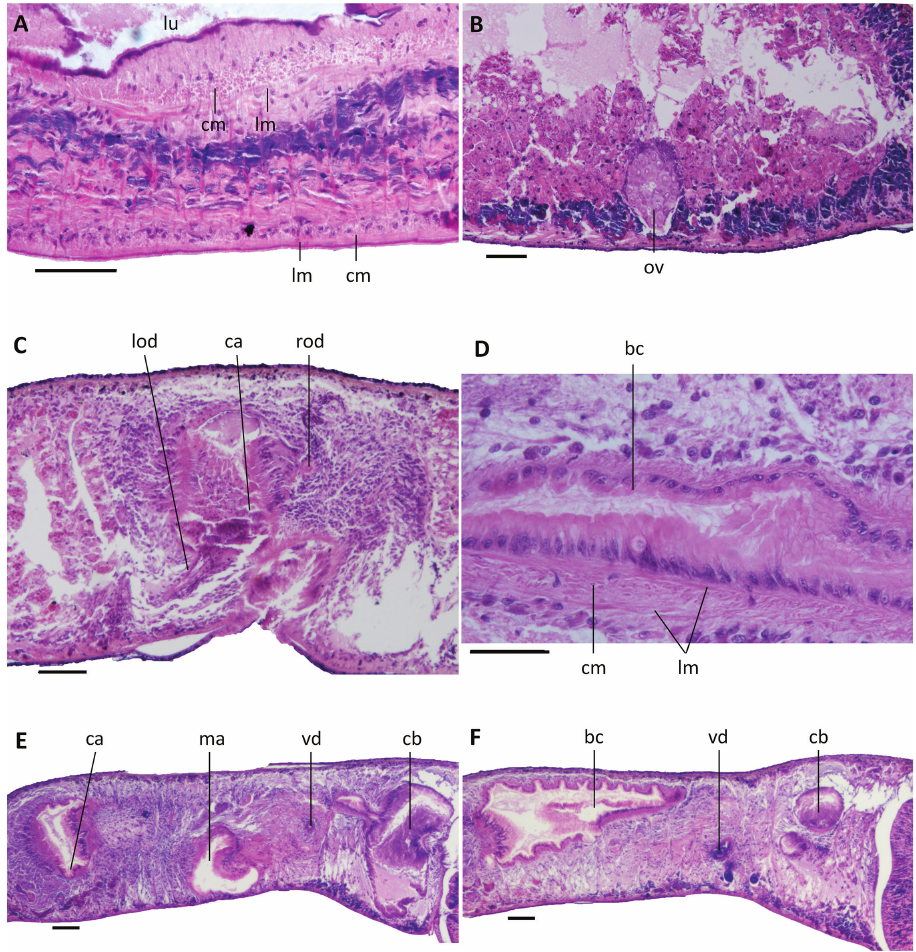
Figure 11. Dugesia verrucula A sagittal section of paratype RMNH VER. 19975.a, showing the musculature of the pharynx B sagittal section paratype RMNH VER. 19975.a, showing an ovary C transverse section of paratype ZJYA7, showing asymmetrical openings of the oviducts D sagittal section of paratype ZJYA11, showing musculature of bursal canal E sagittal section of paratype ZJYA11, showing copulatory bursa F sagit- tal section of paratype ZJYA11, showing wide portion of bursal canal, with its pleated walls. Abbreviations: bc: bursal canal; ca: common atrium; cb: copulatory bursa; cm: circular muscles; lm: longitudinal muscles; lod: left oviduct; lu: lumen; ma: male atrium; ov: ovary; rod: right oviduct; vd: vas deferens. Scale bars: 100